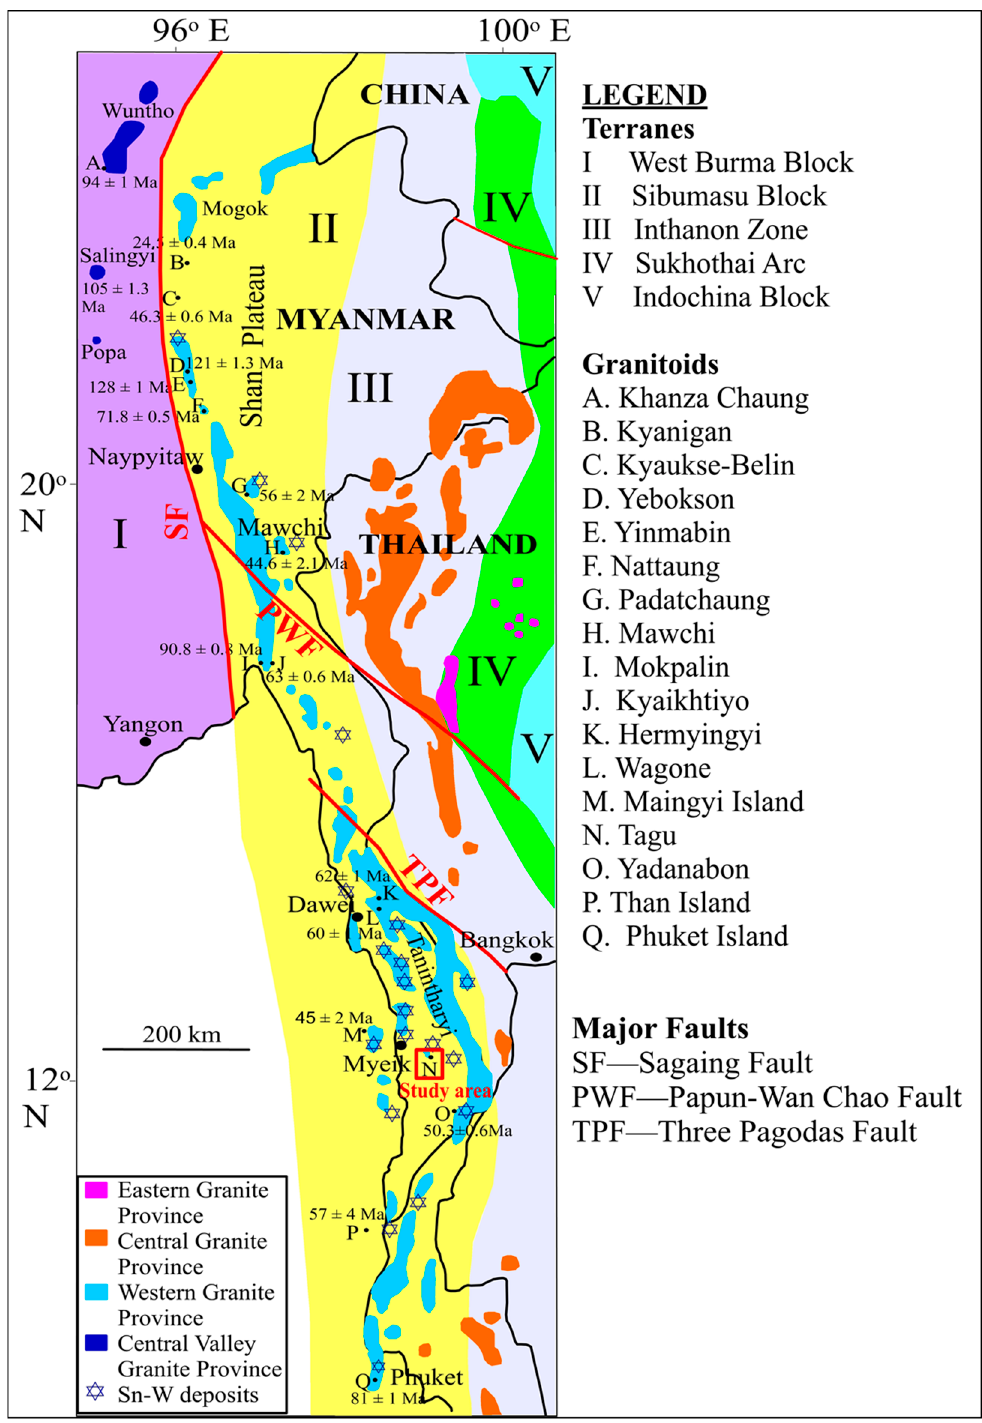
Figure 1. Granitoid provinces of Southeast Asia with major sutures and faults, showing locations of major Sn–W deposits and the studied area (after